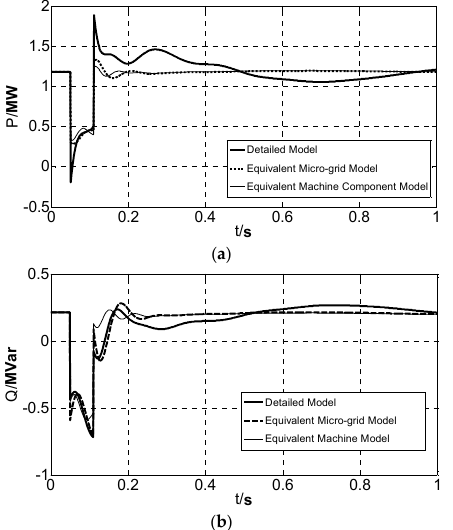
Figure 9. ( a ) Dynamics of Active Power of different models. ( b ) Dynamics of Reactive Power of different models.